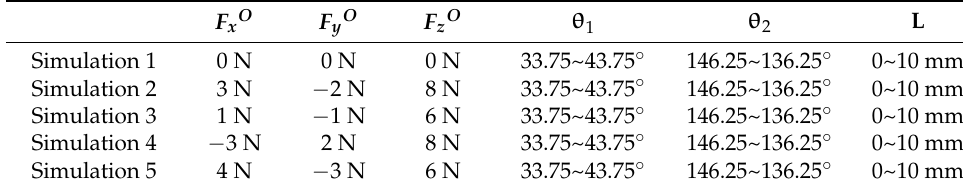
Table 2. Parameters of simulations.